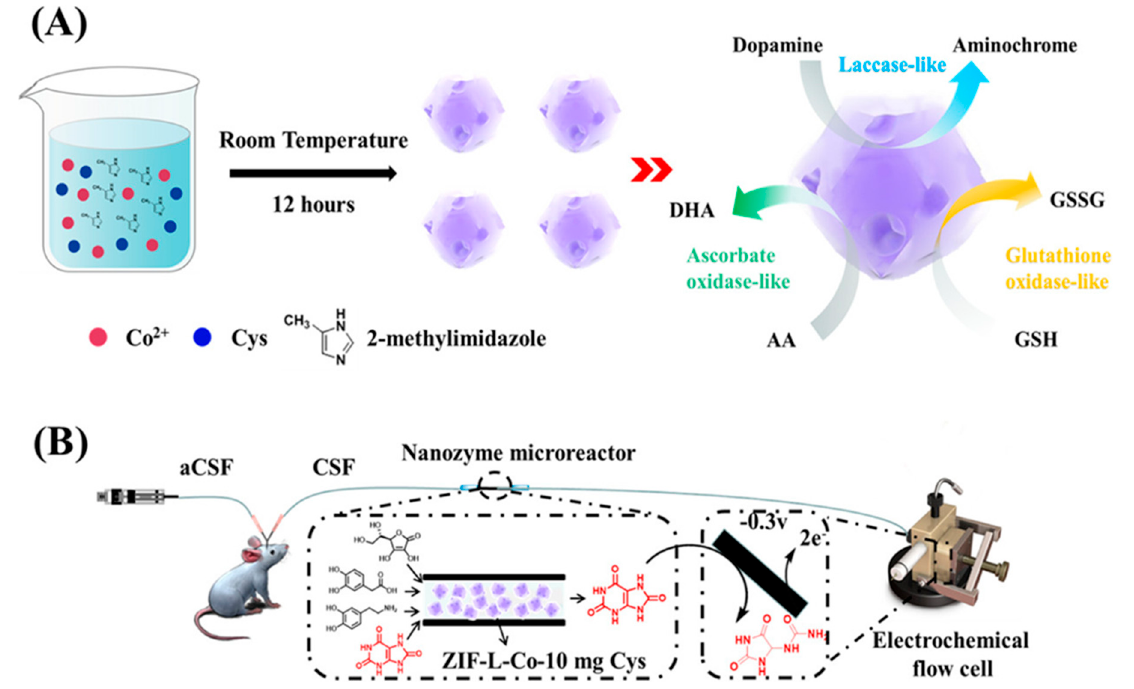
Figure 19. The schematic of the synthesis route of Co@NCNTs/NC and the sensing process [124]. Copyright: Elsevier B.V.